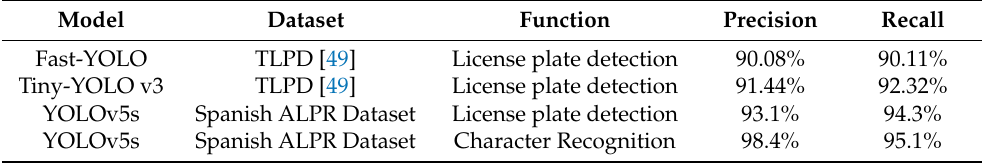
Table 7. Metrics of YOLOv5s trained with Spanish ALPR Dataset.